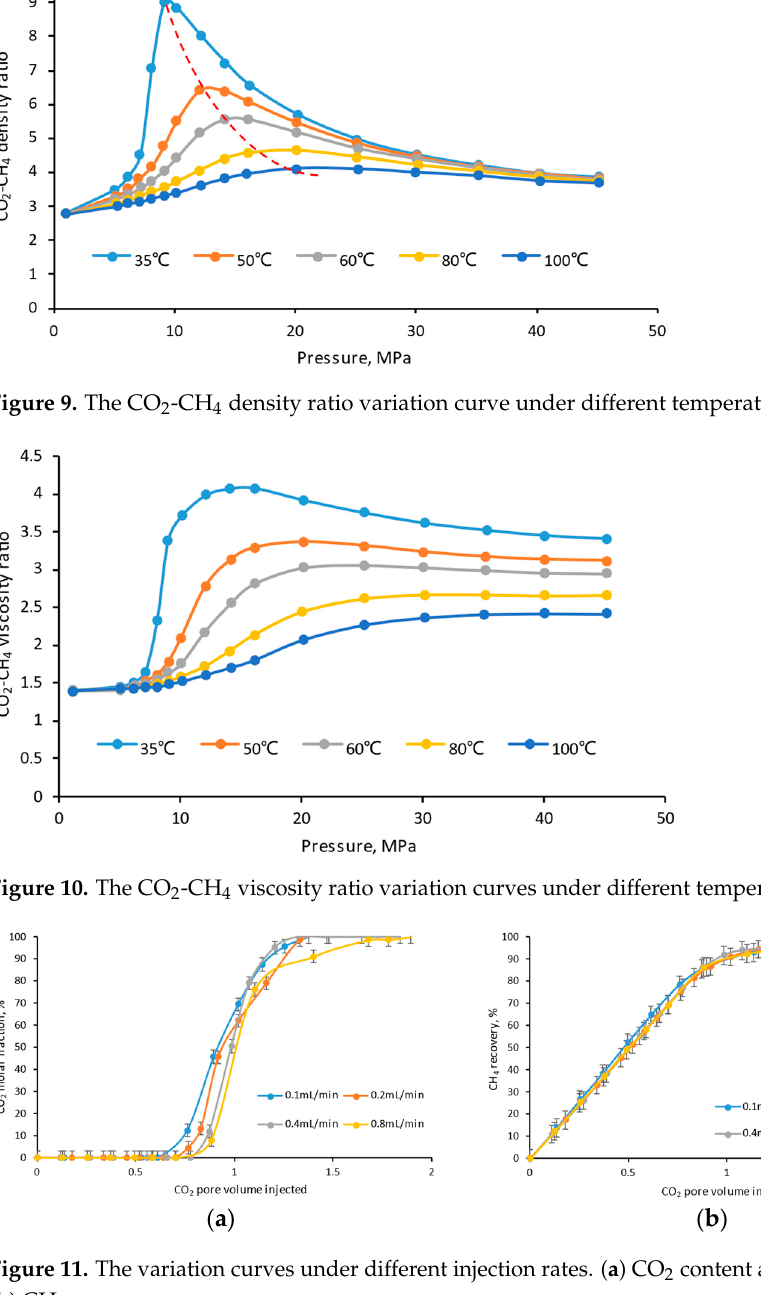
Figure 8. The CO 2 Z factor variation curve under different temperatures and pressures.